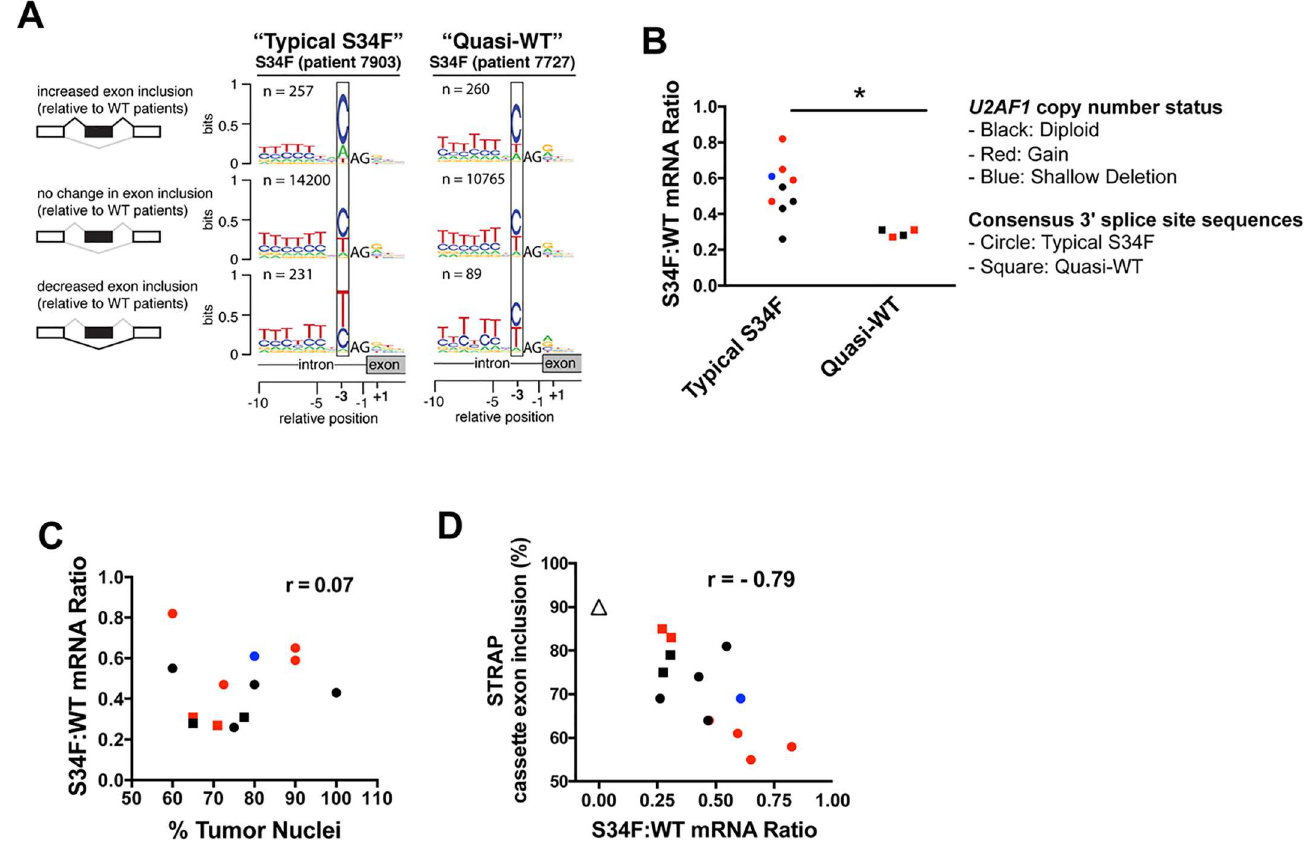
Fig 1. S34F-associated splicing program correlateswith S34F:WT mRNA ratios in LUAD. (A) . Different consensus 3 0 splice site sequences preceding cassette exons for two representative LUADs with the S34F mutation computed from publishedTCGA transcriptomes. In both cases, changes in the use of cassette exons were determinedby comparisons with an average transcriptome from LUADs without U2AF1 mutations. Boxes highlight nucleotides found preferentially at the -3 position. The nucleotide frequenciesprecedingexons that are more often includedor more often excludedin tumors with the S34F mutation differ from the genomic consensus in the tumor from patient #7903, which represent “typical S34F” consensus 3 0 splice sites, but not in the tumor from patient #7727, which represent “quasi-WT” consensus 3 0 splice sites. (Consensus 3 0 splice sites from transcriptomes of every S34F-mutant LUAD are presented in S1 Fig). The analysis was restricted to introns with canonicalGT-AG U2-type splice sites. The invariableAG at the 3 0 splice site was not plotted to scale in order to highlight the consensus sequencesat the -3 position. The vertical axis represents the informationcontent in bits (the maximal value is two. Zero to one bit is shown). n is the number of cassette exon sequences used to construct the logo. A cartoon illustrating alternativesplicing of a cassette exon (black box) is shown on the left side of the sequence logo. Black lines over splice junctions illustrate the S34F-promoted isoform for each comparison. (B) . U2AF1 -mutant LUAD transcriptomes harboring“typical S34F” consensus 3 0 splice sites have relatively high S34F:WT mRNA ratios. U2AF1 -mutant LUAD samples were groupedbased on the nature of the consensus 3 0 splice sites. The asterisk represents a statistically significant changeby Student’s t test. (C) . S34F:WT U2AF1 mRNA ratios do not correlate with tumor purity in LUAD tumors with the S34F mutation. Tumor purity is represented by the percent of tumor nuclei in each LUAD sample (derived from TCGA clinical data) and plotted against the S34F:WT mRNA ratios. (D) . Inclusionof the STRAP cassette exon correlates with the S34F:WT mRNA ratio. Same as Panel C but the S34F:WT mRNA ratio is plotted against the inclusionfrequencyfor the STRAP cassette exon. The medianinclusionlevel of the same cassette exon for all transcriptomes from tumors without a U2AF1 mutation (S34F:WT mRNA ratio = zero) is shown as a triangle. r, Pearson’s correlationcoefficient. In panelsB–D, circles represent samples with typical-S34F consensus 3 0 splice site sequences; squares represent samples with quasi-WT consensus 3 0 splice site sequences. Colors indicate U2AF1 copy number status as calculated by GISTIC 2.0 (See details in the Supplemental Materials and Methods): black, diploid; blue, shallow deletion; red, gain.